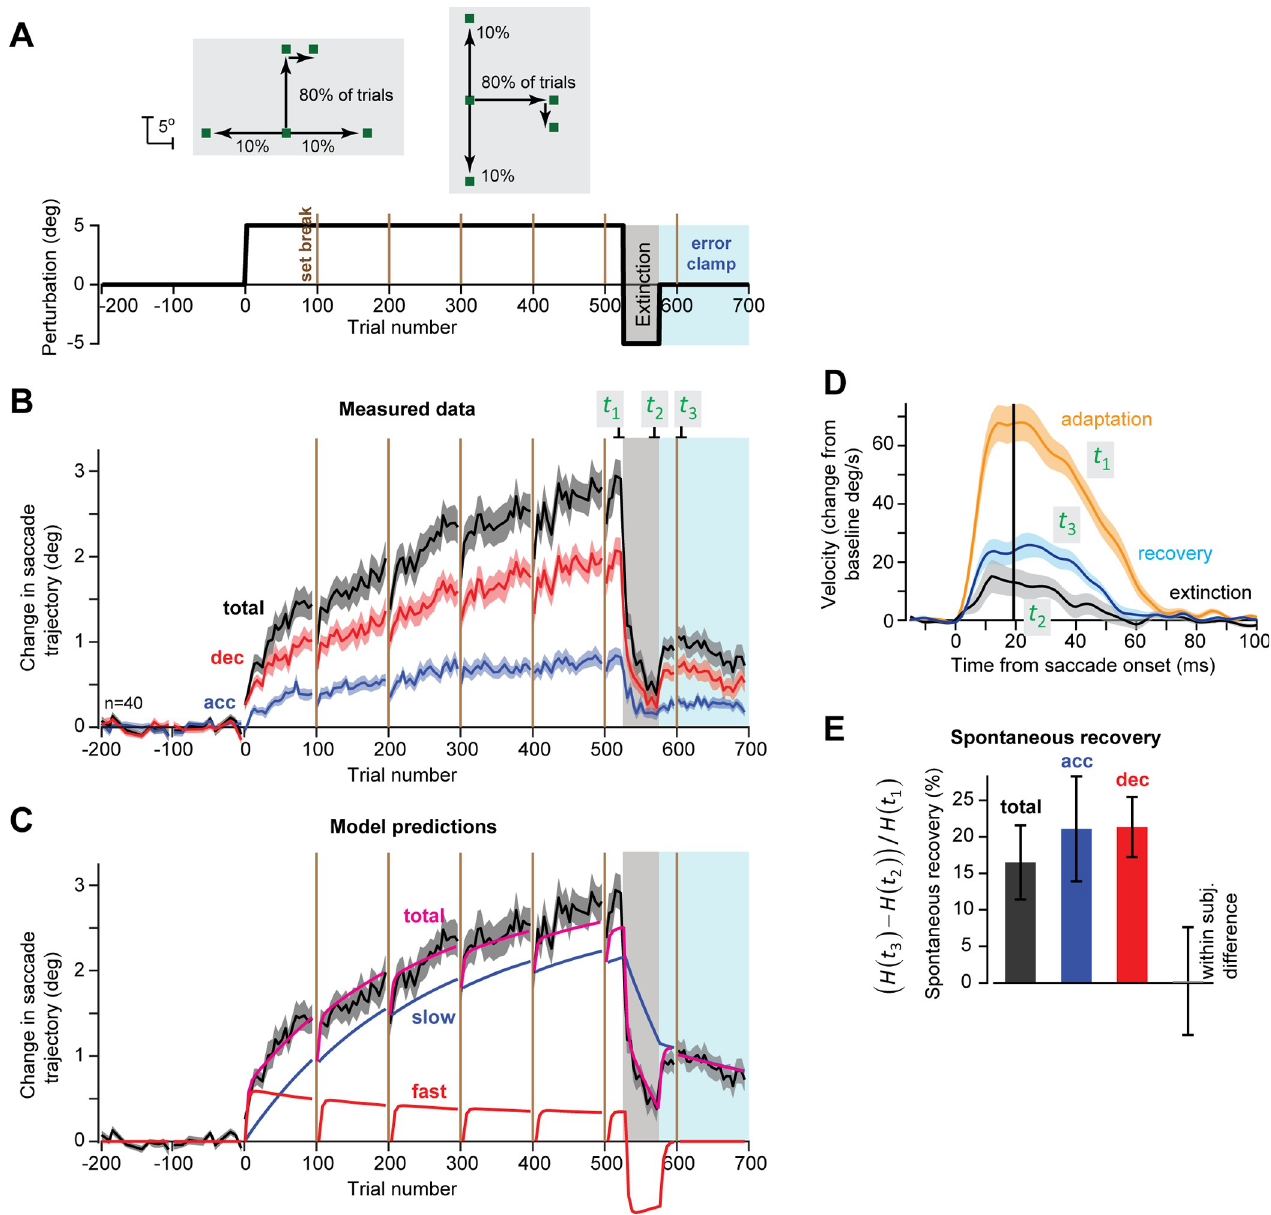
Fig 3. Experiment 2. Both acceleration and deceleration period commands exhibit spontaneous recovery. A . Experimental design. Perturbation block was followed by an extinction block, and then a block of error clamp trials. Half of the subjects experienced horizontal errors following vertical saccades (left panel), while the other half experienced vertical errors following horizontal saccades (right panel). B . Measured data. C . A standard two-state model was fit to the measured data (trace labeled total). The fast and slow states that are predicted by the model are shown. D . Eye velocity in the direction of error during the trials at end of adaptation ( t 1 ), at end of extinction ( t 2 ), and during error clamp ( t 3 ). E. Spontaneous recovery, defined as [ H ( t 3 ) − H ( t 2 )]/ H ( t 1